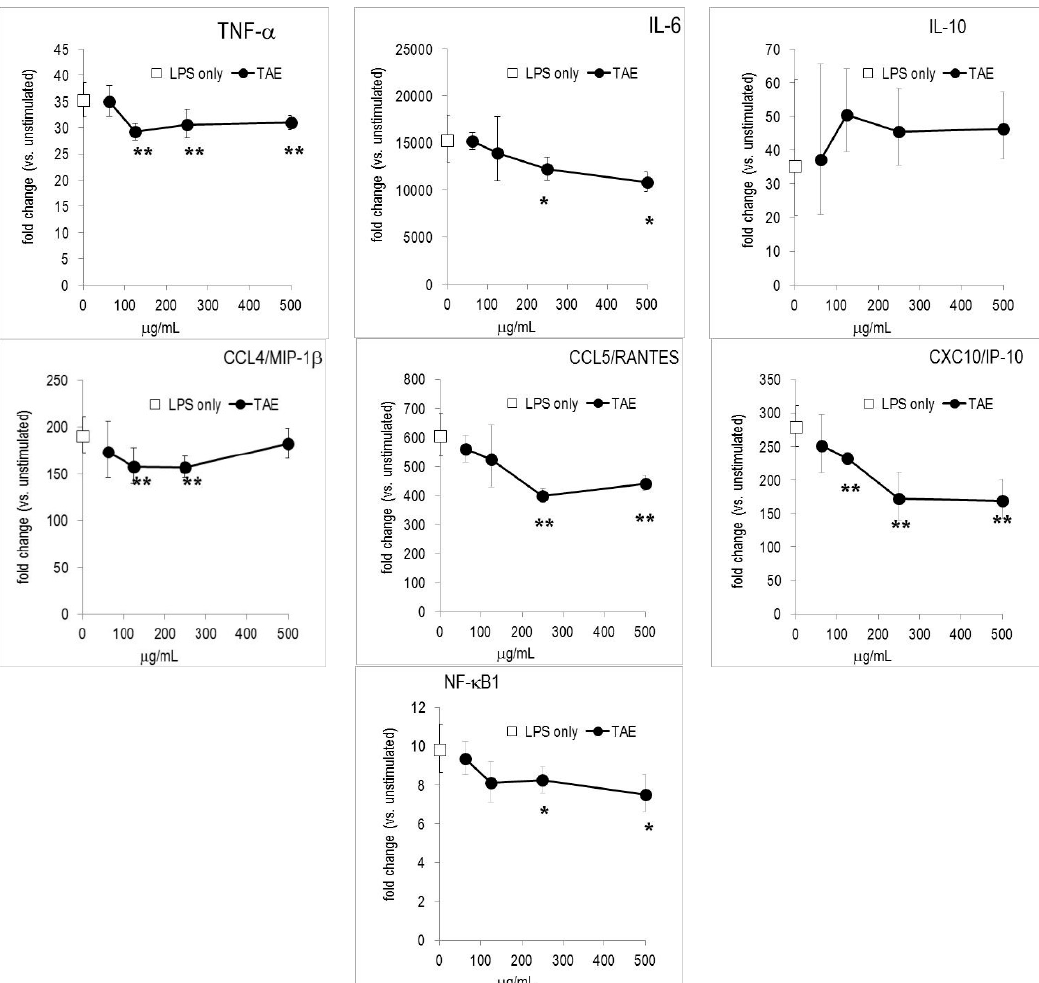
Figure 2. TAE modifies gene expression in LPS-stimulated RAW264.7 cells. Cells were incubated with TAE, stimulated with 1 μ g/mL LPS and cultured for 4 h. Gene expression was quantified by RT-PCR and the data expressed as fold change compared to levels observed in unstimulated cells. Mean ± standard errors of duplicates are given. “LPS only”: indicates the value obtained from LPS-stimulated cells (without substance) and is indicated on the y-axis. * p < 0.05, ** p < 0.01 ( vs. LPS-stimulated cells).